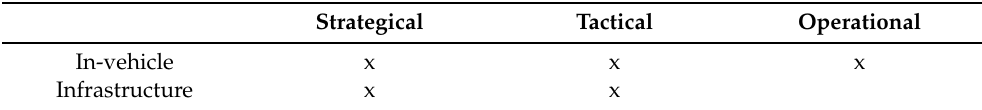
Table 1. Overview of in-vehicle and infrastructure-based systems’ contributions to road vehicle au-